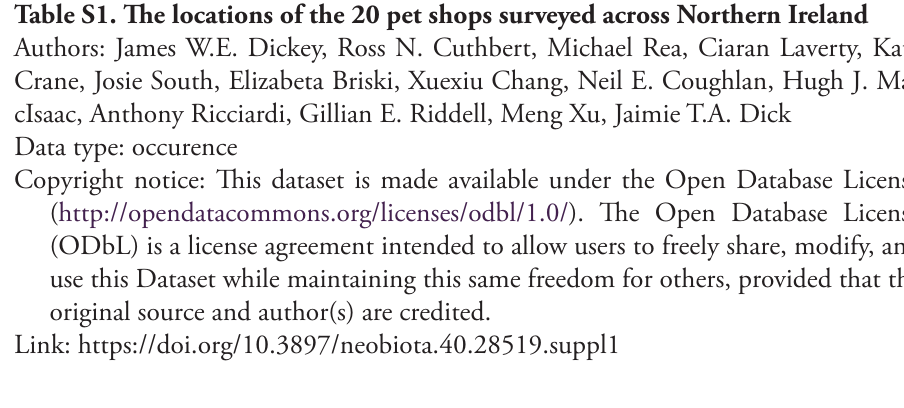
Table S1. The locations of the 20 pet shops surveyed across Northern Ireland